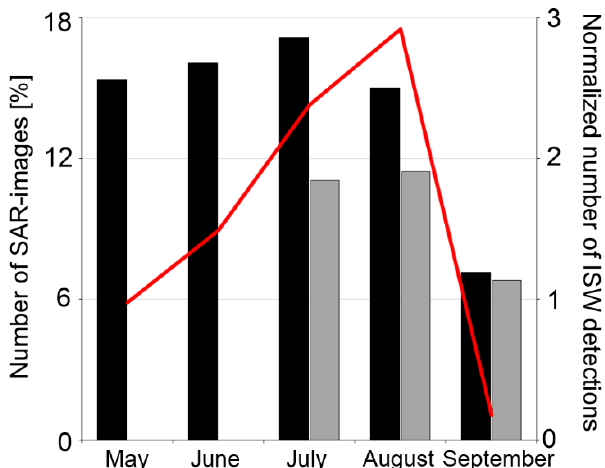
Figure 4. Histogram distribution of the number of available SAR images (black and grey bars, left axis) and the normalized number of ISW detections (red line, right axis) per month during May – September of 2007 – 2013. Black (grey) bars indicate the number of medium (high)-resolution SAR images.